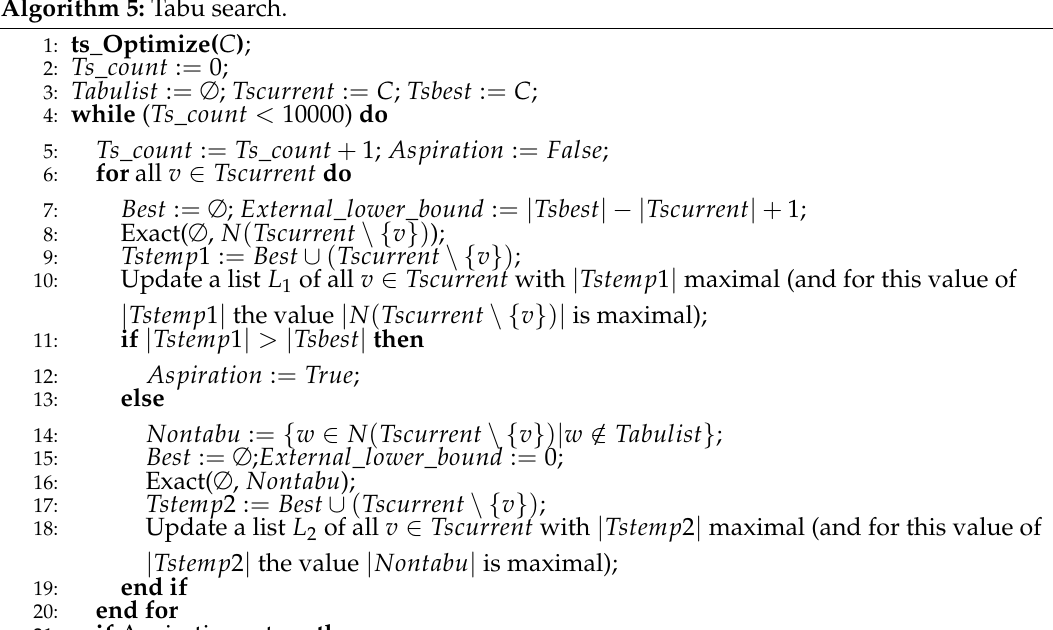
Algorithm 5: Tabu